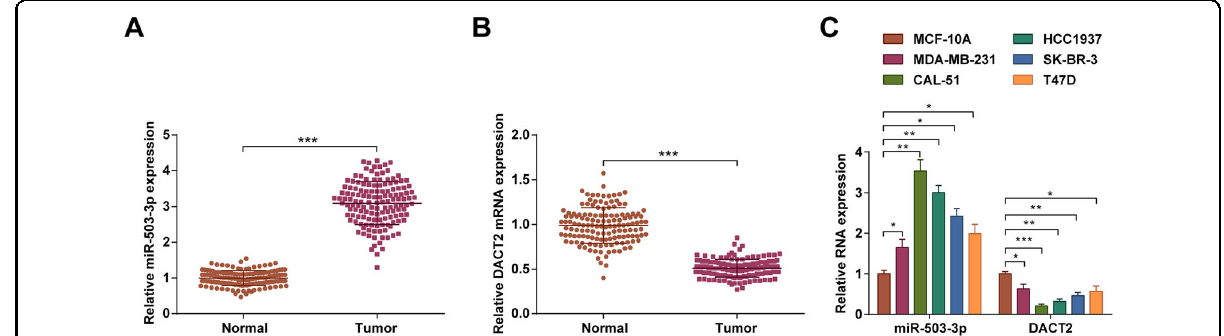
Fig. 1 MiR-503-3p is upregulated while DACT2 is downregulated in BC tissues and cell lines. A , B RT-qPCR measured miR-503-3p and DACT2 mRNA expression in clinical samples, n = 141; C RT-qPCR measured miR-503-3p and DACT2 expression in BC cell lines and MCF-10A cells, repetitions = 3; * P < 0.05; ** P < 0.01; *** P < 0.001; miR-503-3p and DACT2 expression in clinical samples were detected using paired double-sample Student ’ s t test and data of groups were compared using Student ’ s t